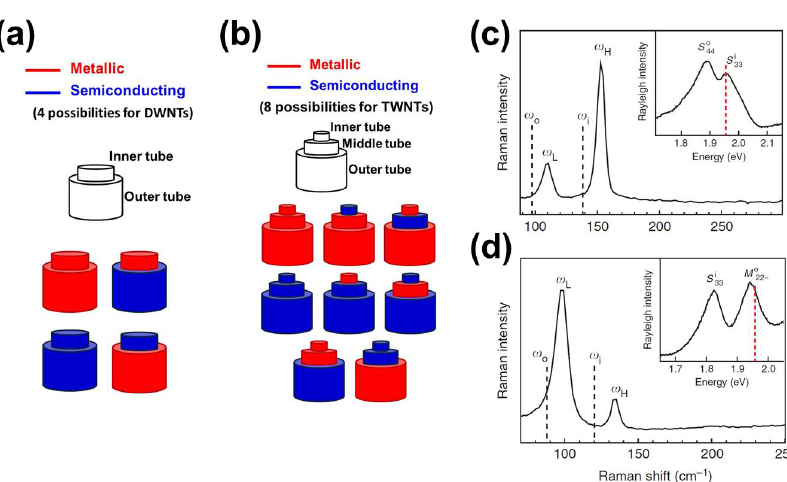
Figure 3. Illustration of the possible flavors or metallicities to be obtained for ( a ) double-walled carbon nanotubes and ( b ) triple-walled carbon nanotubes. ( c ) The Raman spectrum of a ( 18,5 ) @ ( 27,5 ) double-walled carbon nanotube (DWNT) and ( d ) the Raman spectrum of a ( 15,13 ) @ ( 31,4 ) DWNT. Both spectra show a strong blueshift in the radial breathing mode (RBM) frequencies from those SWNTs constituting the DWNTs (shown by the dashed lines). The insets in ( c ) and ( d ) show the Rayleigh spectra for the respective DWNTs. Reproduced with permission from [56], Copyright Nature Publishing Group,